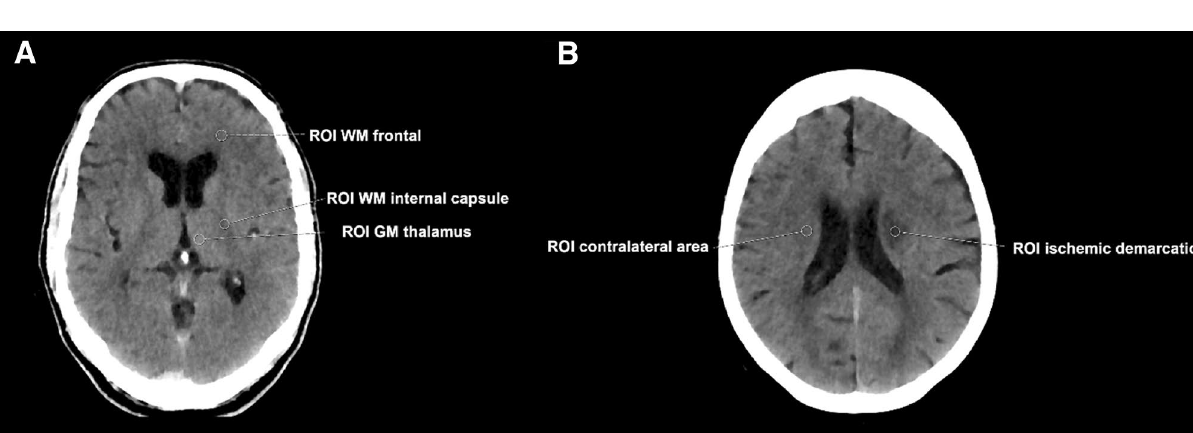
Figure 1. Placement of regions of interest (ROIs). ( A ) Placement of circular ROIs for the white matter (WM) of the left frontal lobe, WM of the left internal capsule, and gray matter (GM) of the left-sided thalamus (using axial slices at the level of the basal ganglia/third ventricle); ( B ) Placement of circular ROIs within ischemic demarcation (adjacent to the left lateral ventricle) and within a homologue, unaffected area of the contralateral hemisphere (using axial slices at the level of ischemic